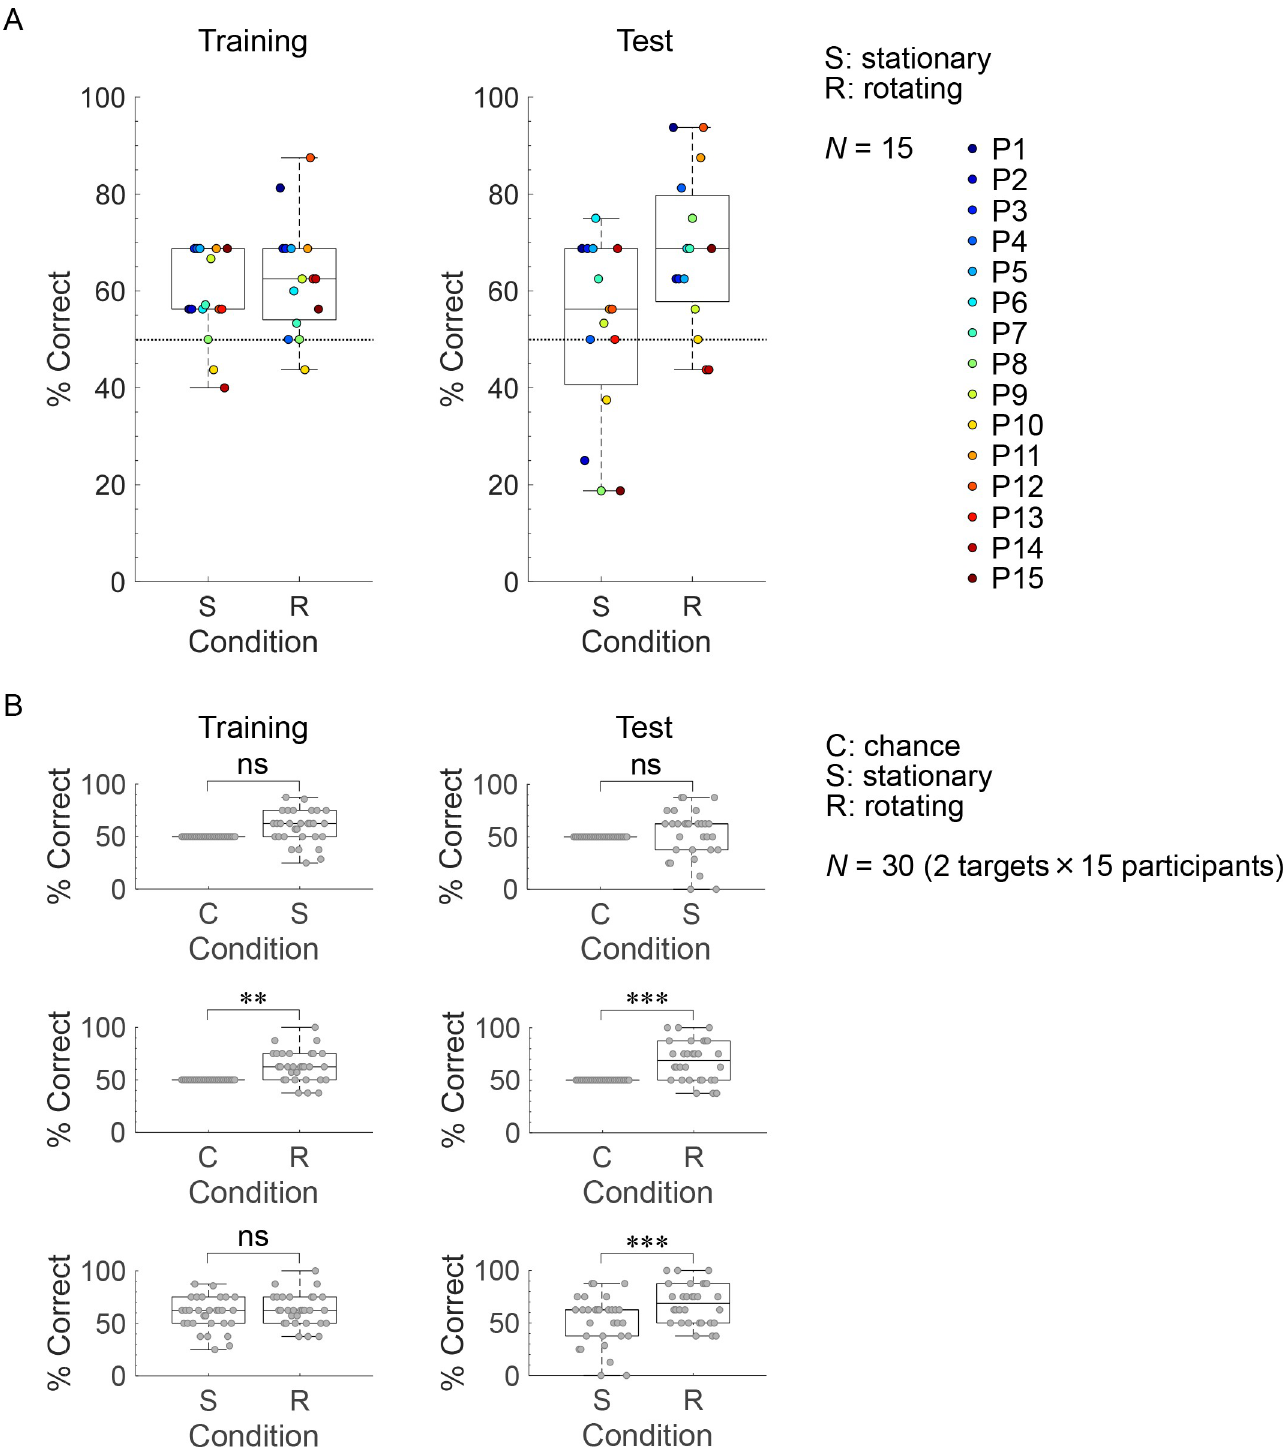
Fig 5. Target geometry identification performance. (A) shows box-and-whisker and scatter plots of the proportions of correct responses (P1–15) in the training (left) and test (right) trials under the stationary (S) and rotating (R) conditions. The horizontal lines in the boxes indicate the median. The bottom and top of the boxes indicate the 25th ( q 1 ) and 75th ( q 3 ) percentiles, respectively. The bottom and top whiskers extend to the minimum and maximum data points within the range of [